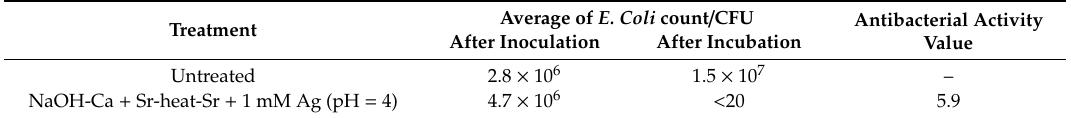
Table 4. Antibacterial activity results on Ti untreated and subjected to NaOH-Ca + Sr-heat-Sr + 1 mM Ag (pH = 4).